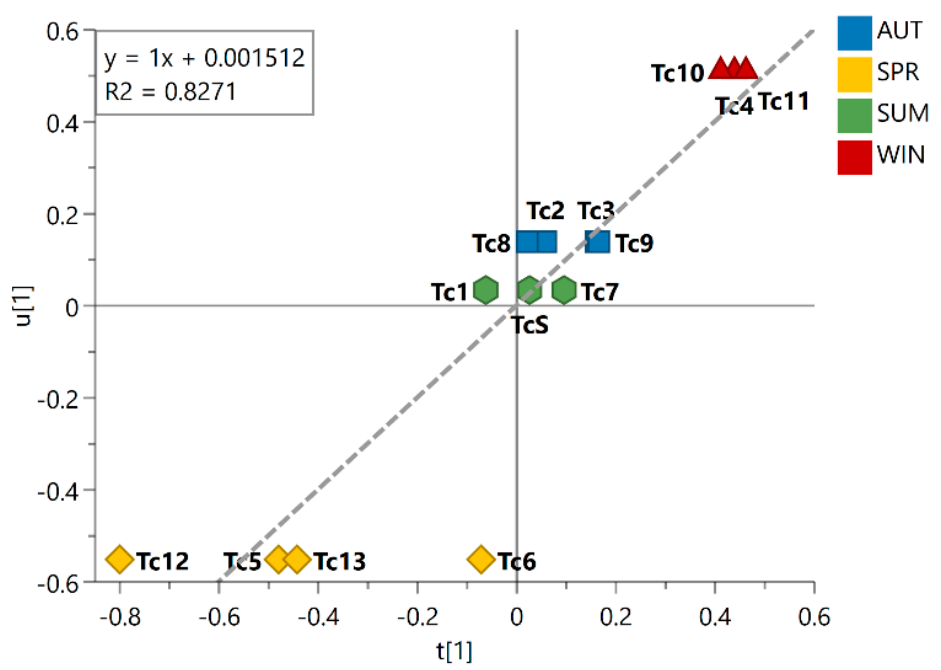
Figure 2. Inner relation plot of the PLS-DA model for season groups. The line in the plot shows the linear relationship between the samples following Spring (SPR), Summer (SUM), Autumn (AUT), and Winter (WIN). Linear regression equation and coefficient of determination R 2 are shown in the graph. Season samples are represented by hexagon—SUM (Tc1, Tc7, and TcS), square—AUT (Tc2, Tc3, Tc8, and Tc9), triangle—WIN (Tc4, Tc10, and Tc11), and diamond—SPR (Tc5, Tc6, Tc12, and Tc13).